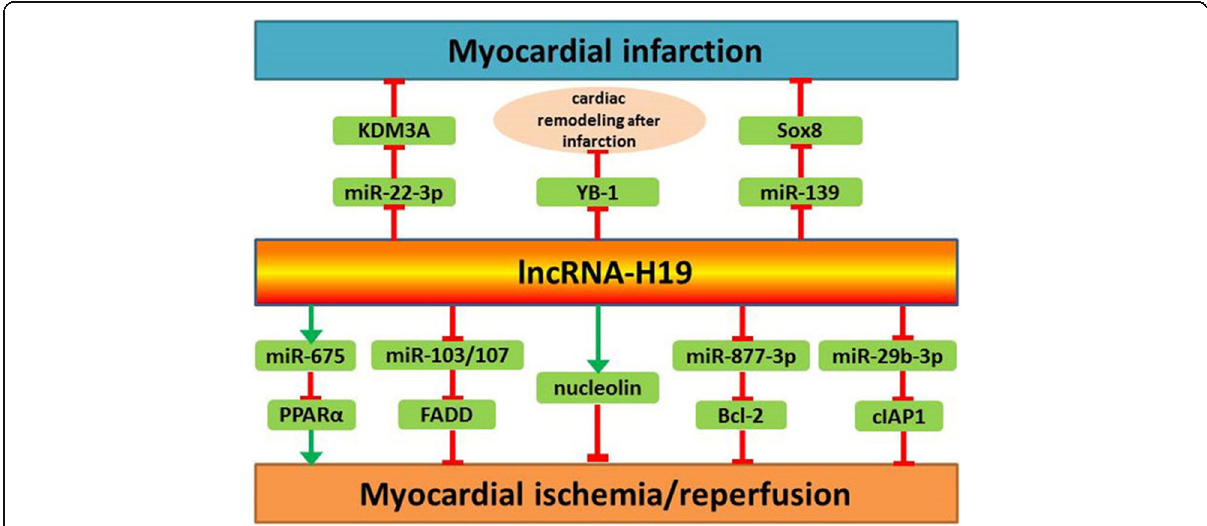
Fig. 2 The role of lncRNA-H19 and its targets in cardiomyocyte injury induced by ischemia/reperfusion or infarction. : aggravate, :